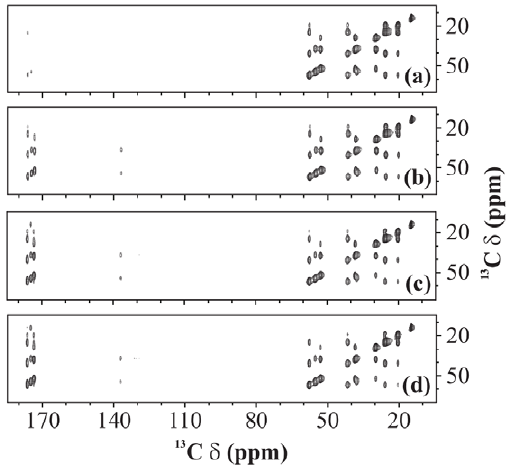
Figure 6. 13 C- 13 C spectra. 2D 13 C- 13 C spectra of U- 13 C-, 15 N-fMLF recorded using PARIS-xy (m=1)(N=1/2) recoupling scheme at MAS frequency of 30 kHz and an external magnetic field of 16.43 T. Mixing- time period in each case was 90 ms. Different proton RF amplitudes of (a) 7.3 kHz, (b) 16 kHz, (c) 24 kHz, and (d) 30 kHz were employed. Only a selected region of 2D spectrum, covering cross-peaks from each class, is shown in each case.